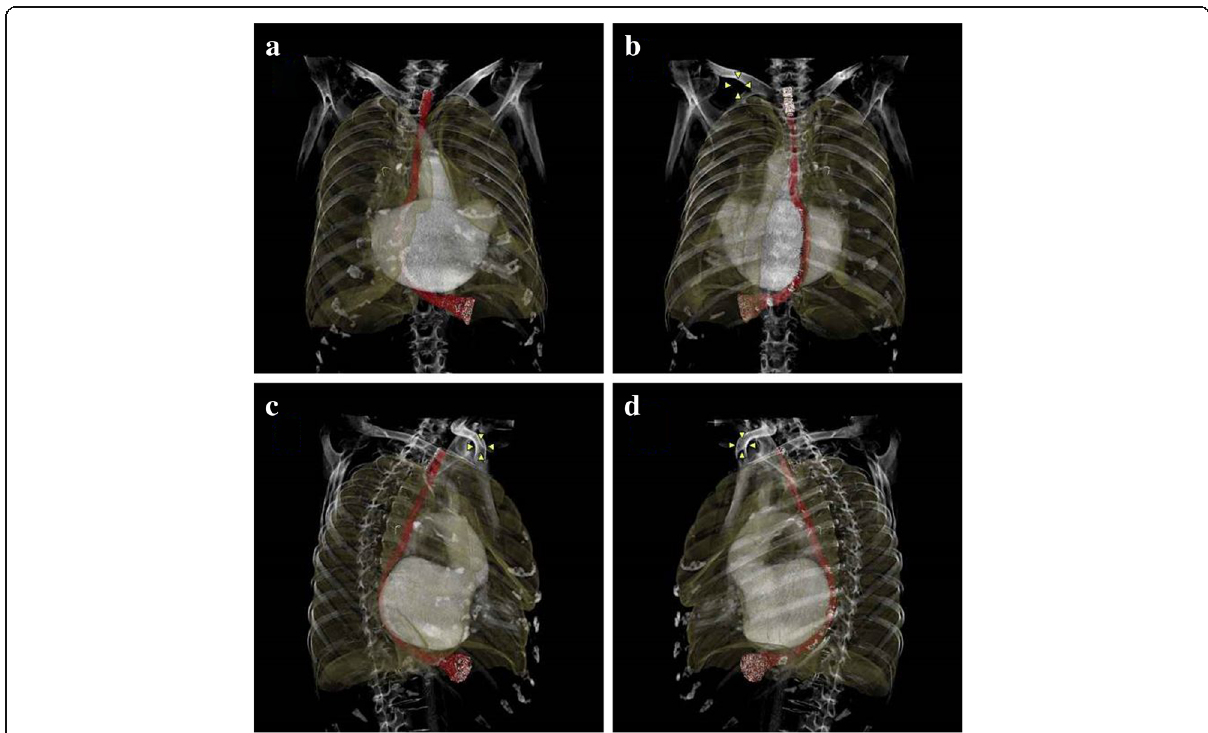
Fig. 2 Three-dimensional images of the esophagus. a Anterior view. b Posterior view. c Right lateral oblique view. d Left lateral oblique view. The course of the esophagus is shown in red. The esophagus was compressed and distorted by the enlarged left